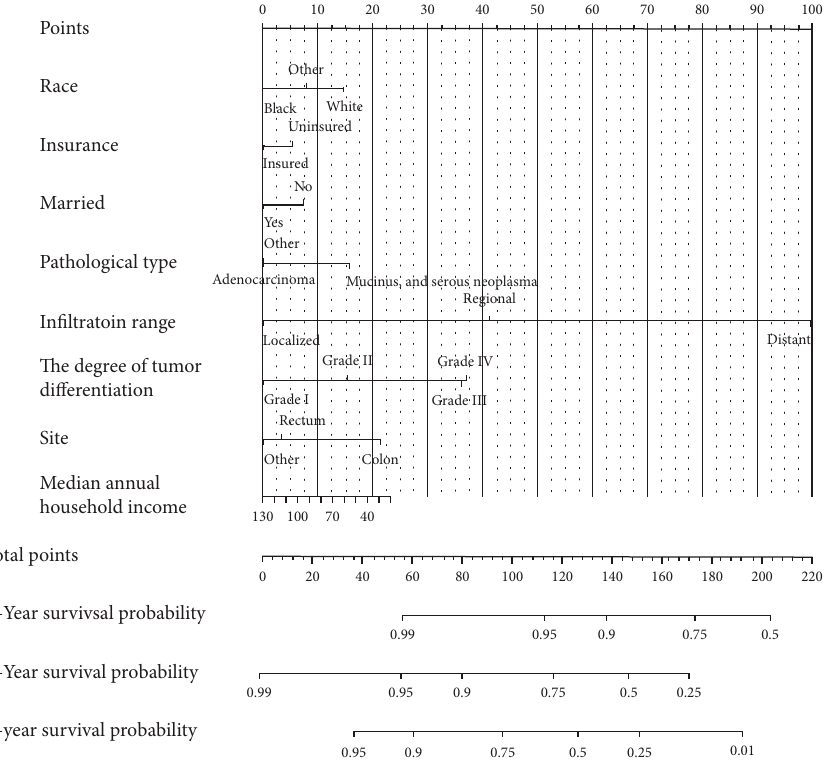
Figure 1: The nomogram of the Cox regression